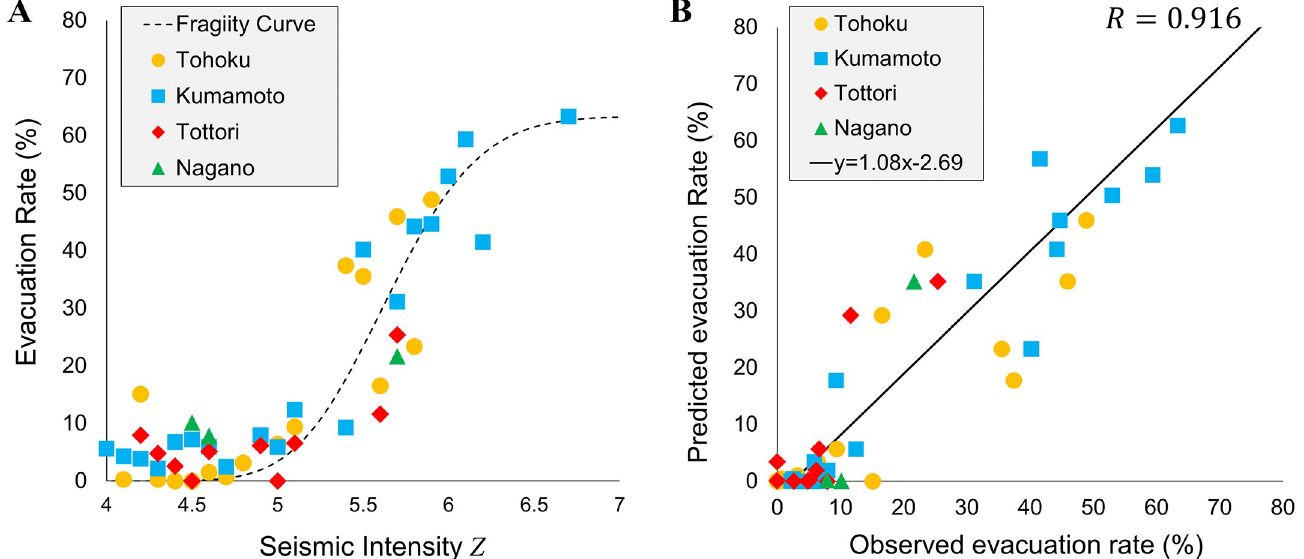
Fig 3. Fragility curves for evacuation rates. A: evacuation rates for each of the four earthquakes plotted against seismic intensities for all affected LGUs, along with the estimated fragility curve. Colors indicate earthquake incident. B: scatter plot of estimated and true evacuation rates.